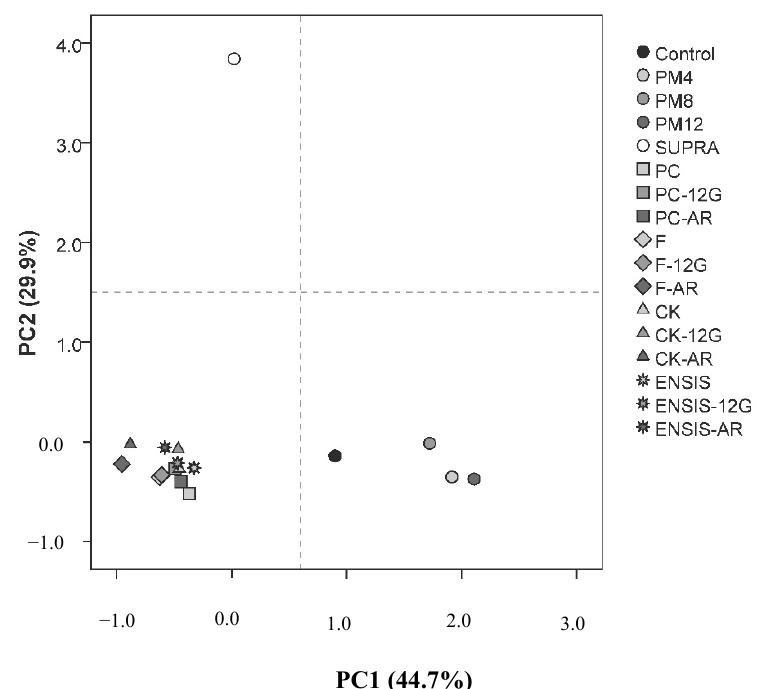
Figure 3. PCA scores of Palomino fino wines elaborated using different vinification techniques. PM4, PM8 and PM12: pellicular maceration for 4, 8 and 12 h, respectively; SUPRA: supra-extraction wine; PC, F, CK and ENSIS: wines elaborated by different yeast strains; 12G and AR: correspond to enzymatic extracts used.